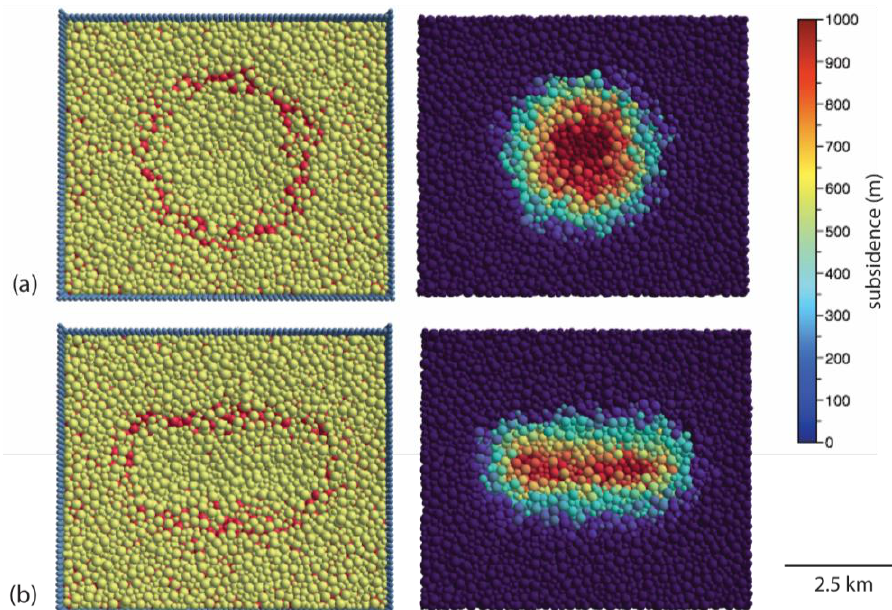
Figure 3. Final surface geometries (left) and total surface subsidence (right) after 1000 m basal piston displacement: experiments with (row a ) circular and (row b ) rectangular piston roofs, respectively.